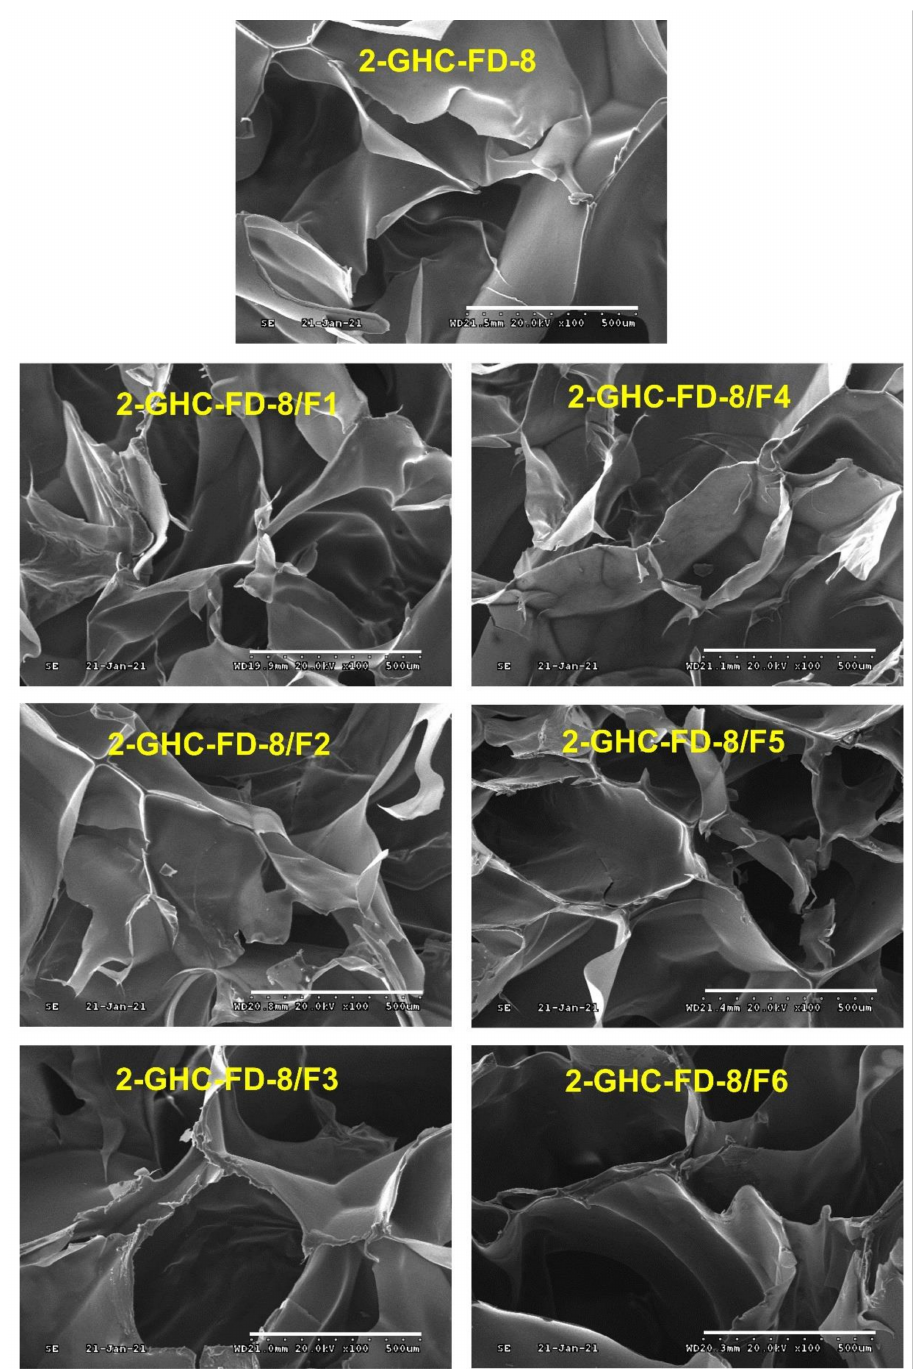
Figure 7. Surface morphologies of 2-GHC-FD-8/F1-6 observed by SEM at 100 × . White scale bars indicate 500 µ